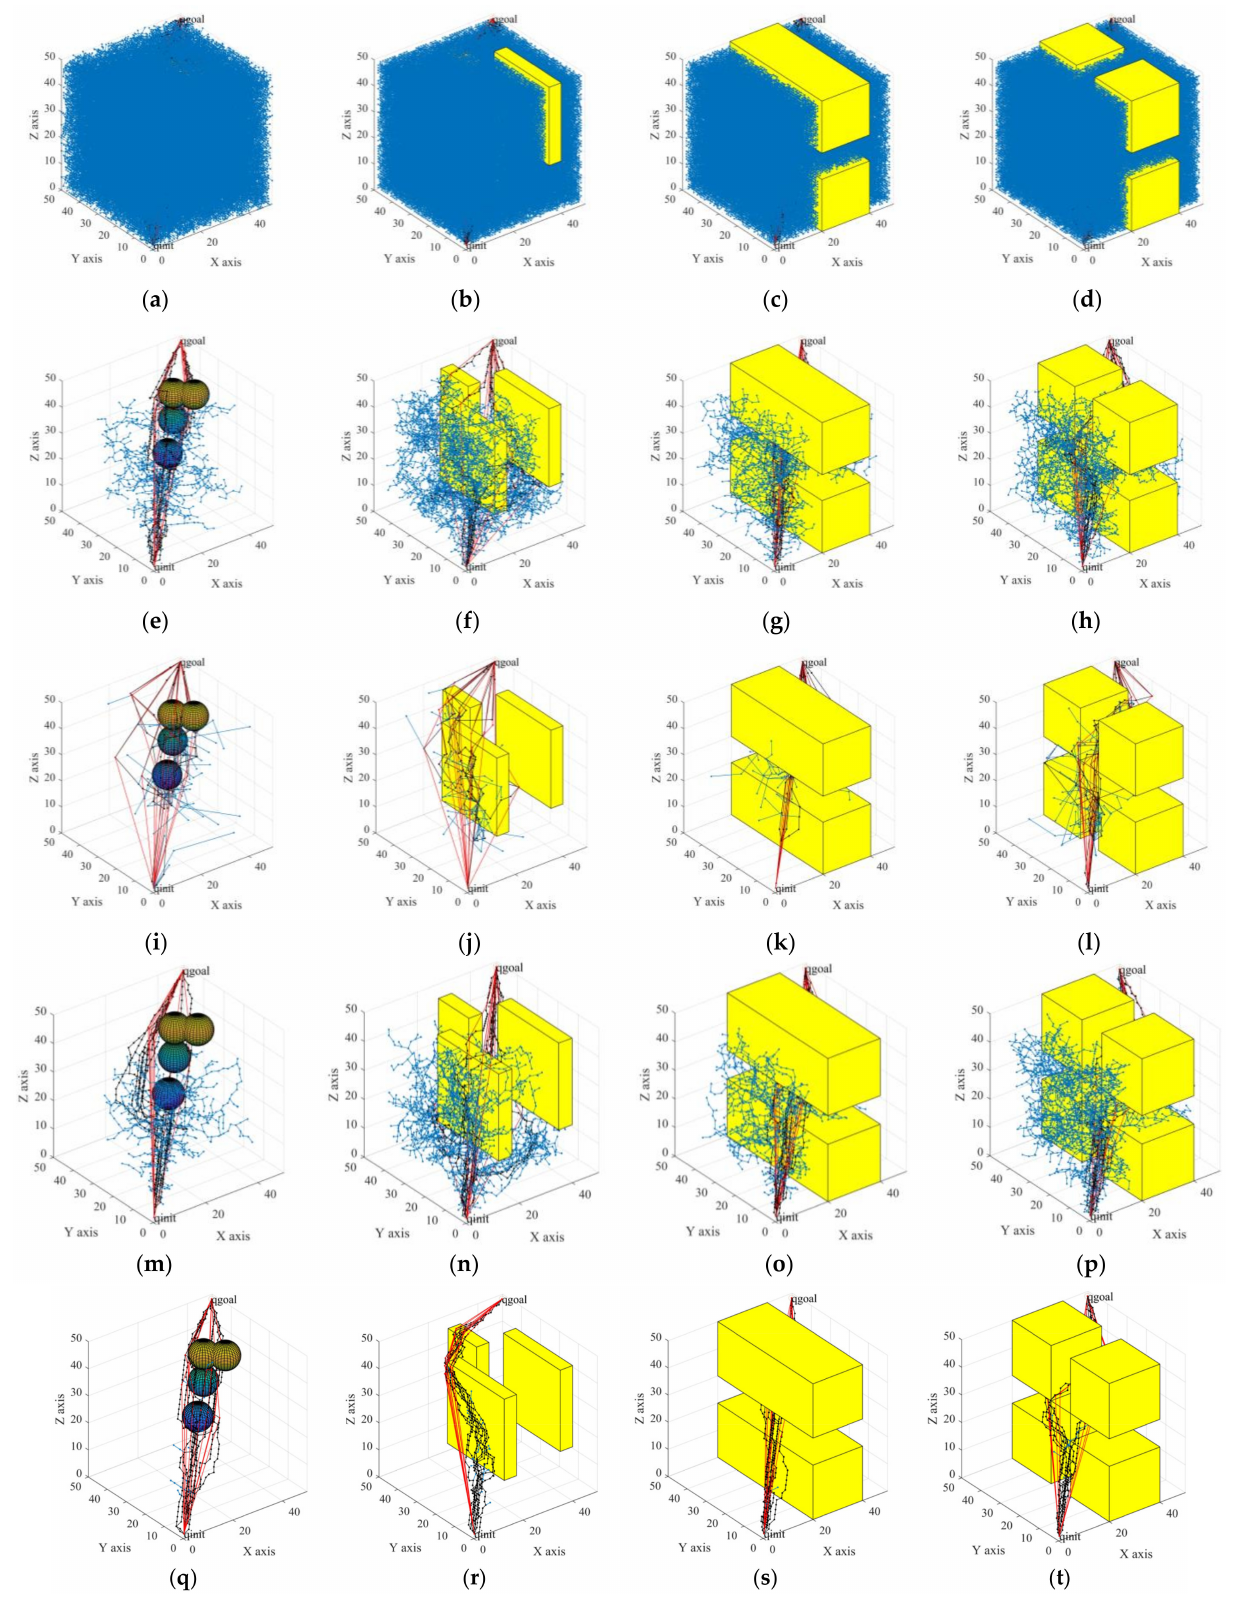
Figure 10. Ten experiments each of: the RRT algorithm ( a – d ); the biased-RRT algorithm with a target offset probability of 50% ( e – h ); the TO-RRT algorithm ( i – l ); the RRT-BCR algorithm ( m – p ); and the NC-RRT algorithm ( q – t